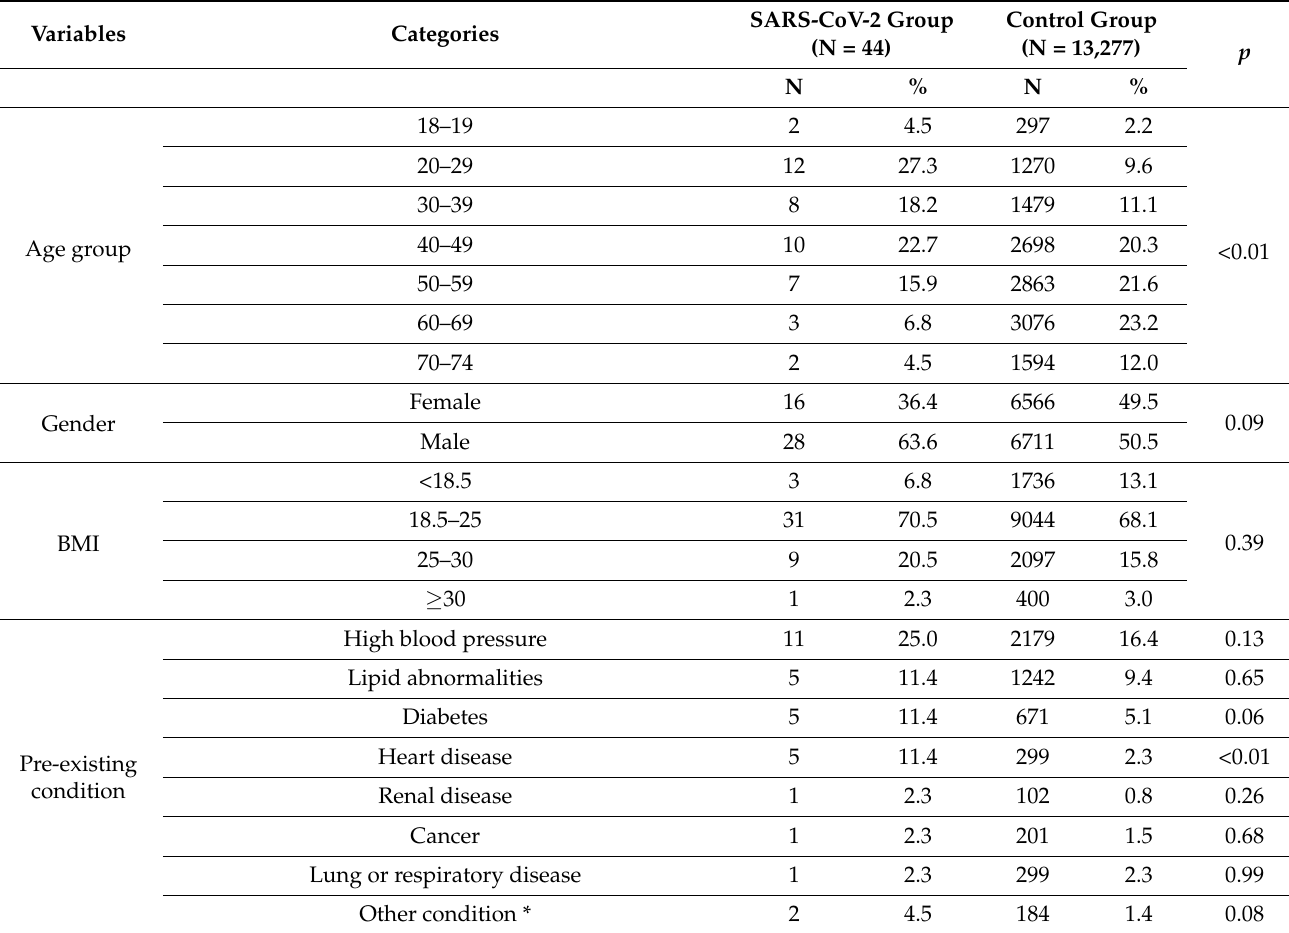
Table 1. Background of the participants. Difference between the SARS-CoV-2 group and the control group were calculated by chi-squared